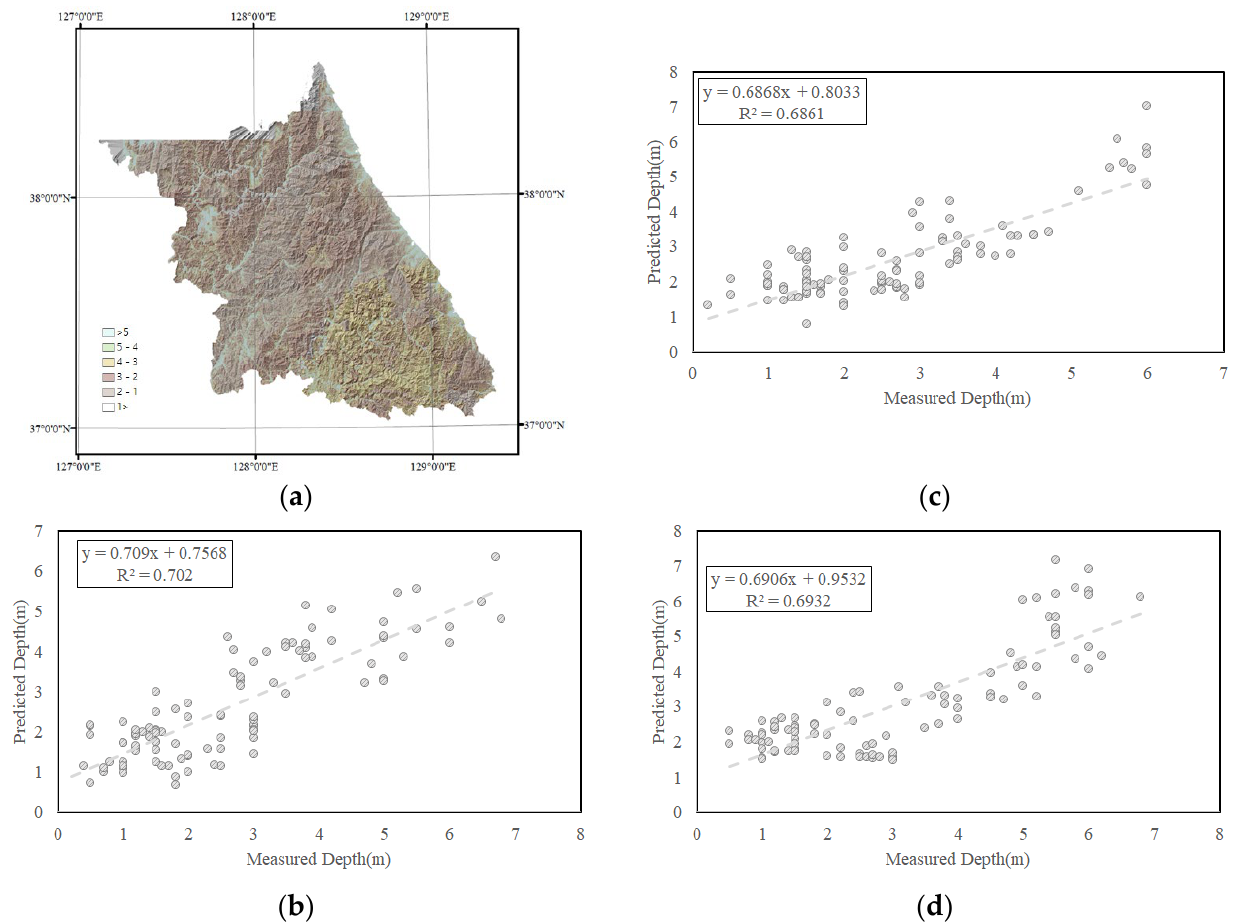
Figure 7 . The proposed statistical prediction models result in the study area, ( a ) The soil depth map, Scatterplots showing the relationship between predicted and measured soil depth for ( b ) Igneous rock ( R 2 = 0.702), ( c ) Metamorphic rock ( R 2 = 0.686), ( d ) Sedimentary rock ( R 2 = Table 5 . The result of soil depth prediction models in this study.